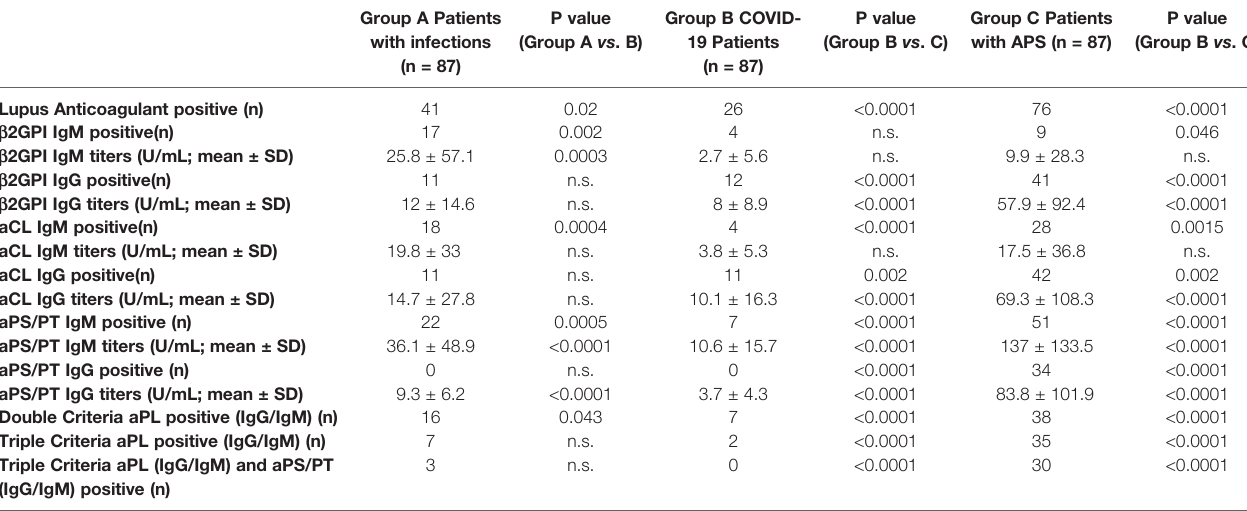
TABLE 1 | Rate of positive antiphospholipid antibodies ’ testing and relative differences between groups.